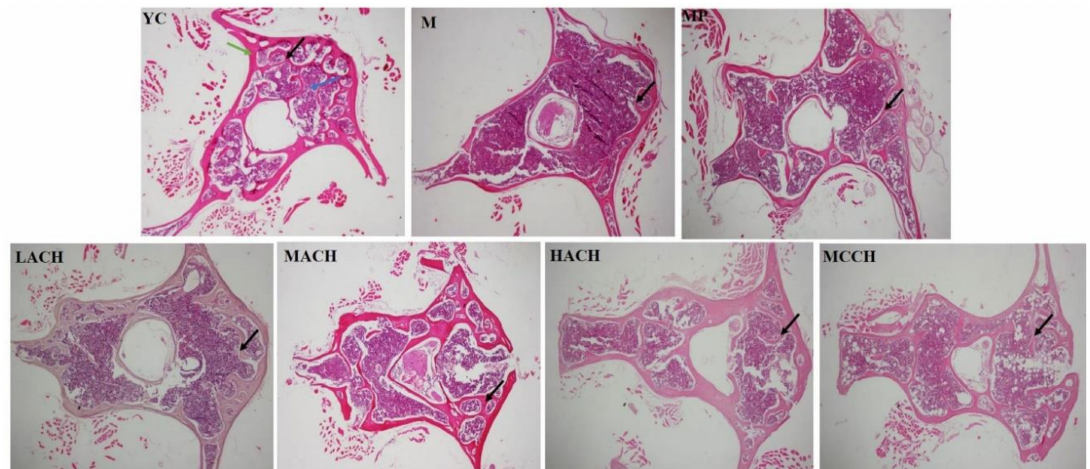
Figure 2. Effect of collagen hydrolysates on vertebral histology in chronologically aged mice (HE, 100 × ). YC, young control group; M, model group; MP, medium dose of proline; LACH, MACH and HACH represent the low, medium and high dose of ACH, respectively; MCCH, medium dose of CCH. Bony trabeculae, bone marrow and cortical bone in lumbar issue were shown as black, blue and green arrows,